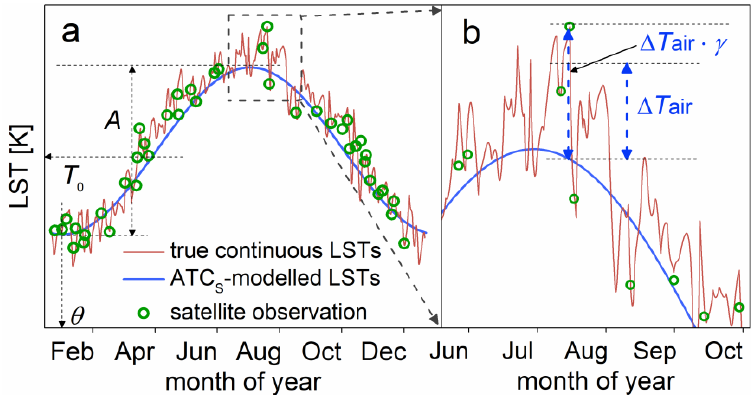
Figure 2. A demonstration of the standard ATC model (represented by the ATC S ) and the observed continuous daily LST dynamics. LST dynamics and the model predictions are presented for ( a ) an entire year and ( b ) a shorter period ranging from Jun. to Oct. T 0 , A , and θ are the annual mean LST, ATC amplitude, and the corresponding phase shift relative to the spring equinox, respectively; Δ T air denotes the SAT fluctuation; and γ is the ratio between the LST and SAT fluctuations.